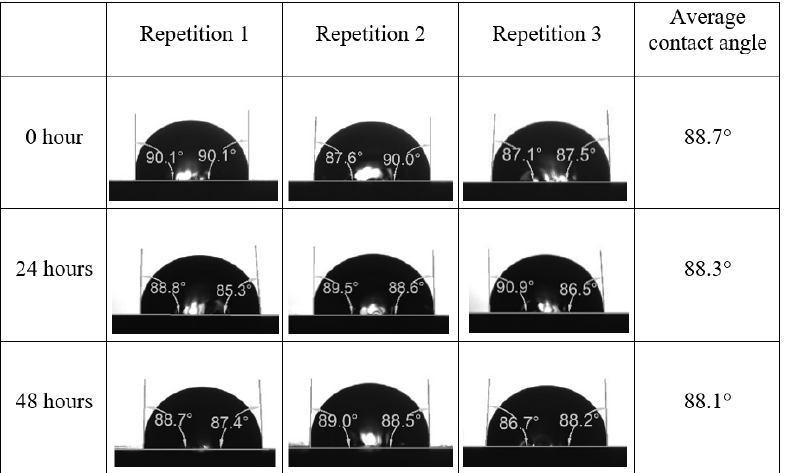
Figure A19. Dynamic Contact Angle Measurement Results for 50% Na 2 SO 4 + 50% CaCl 2 (3500 ppm).